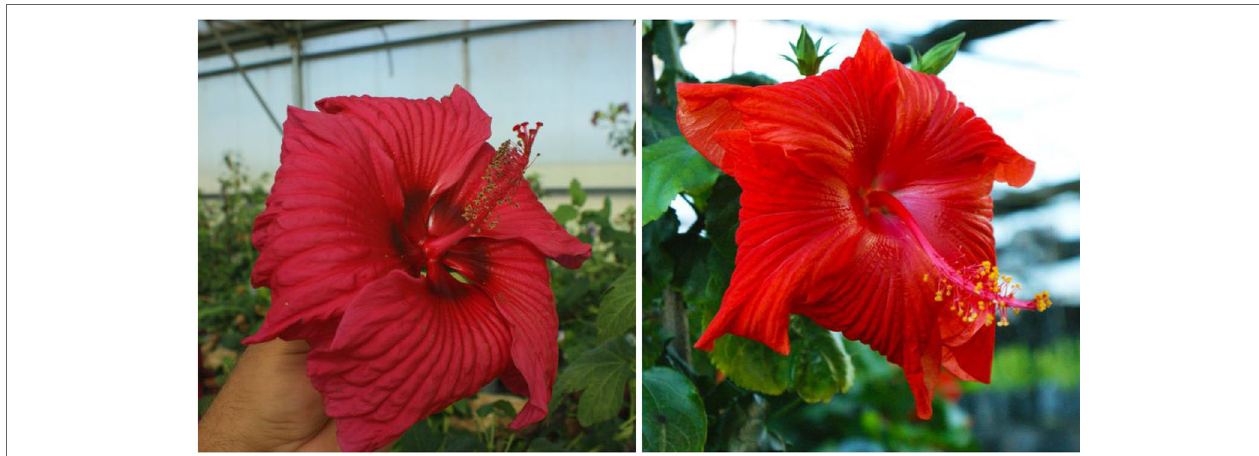
FIGURe 9 | Flower color and shape of H. x moscheutos hybrid “16755-2N” (left) and an interspecific tropical hybrid H. rosa-sinensis x H. schizopetalus “161122- TR” (right). Photo credit: Dariusz P. Malinowski.